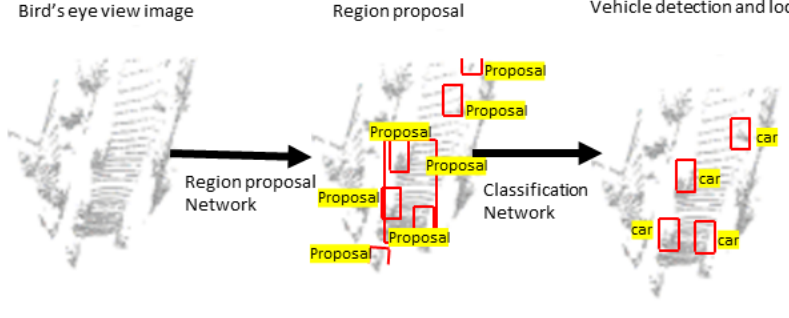
Figure 4. Two-stage vehicle detector